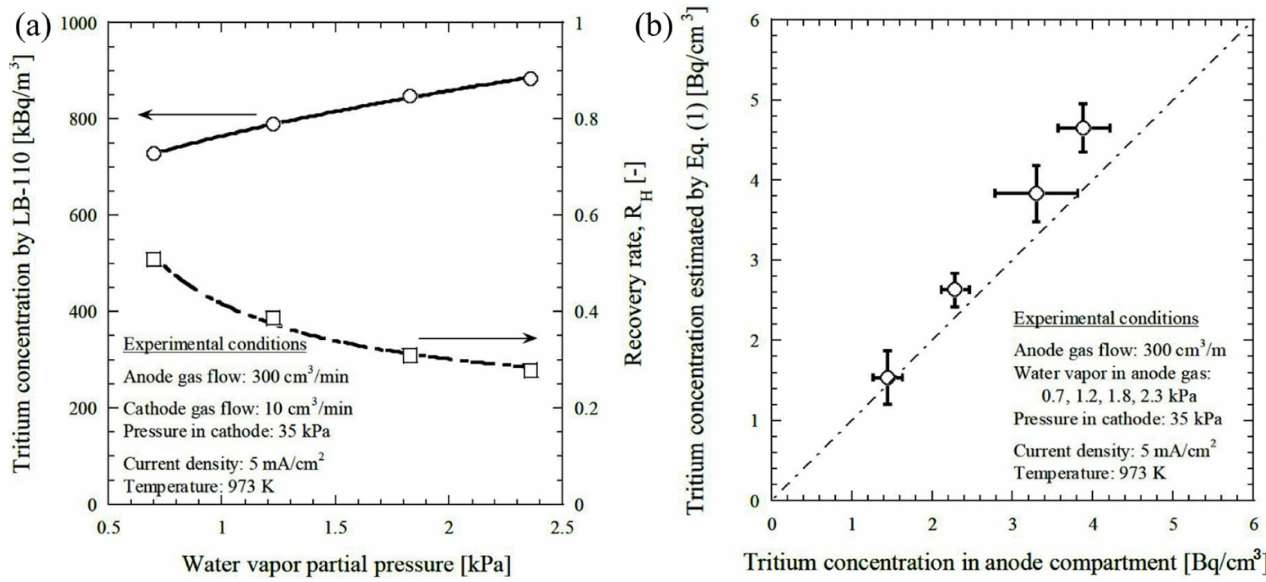
Figure 5. ( a ) Change in tritium concentration and hydrogen recovery rate with water vapor partial pressure, ( b ) relationship between the tritium concentration in anode compartmented the estimated tritium concentration. Reprinted with permission from Ref. [69]. Copyright 2015 Taylor &